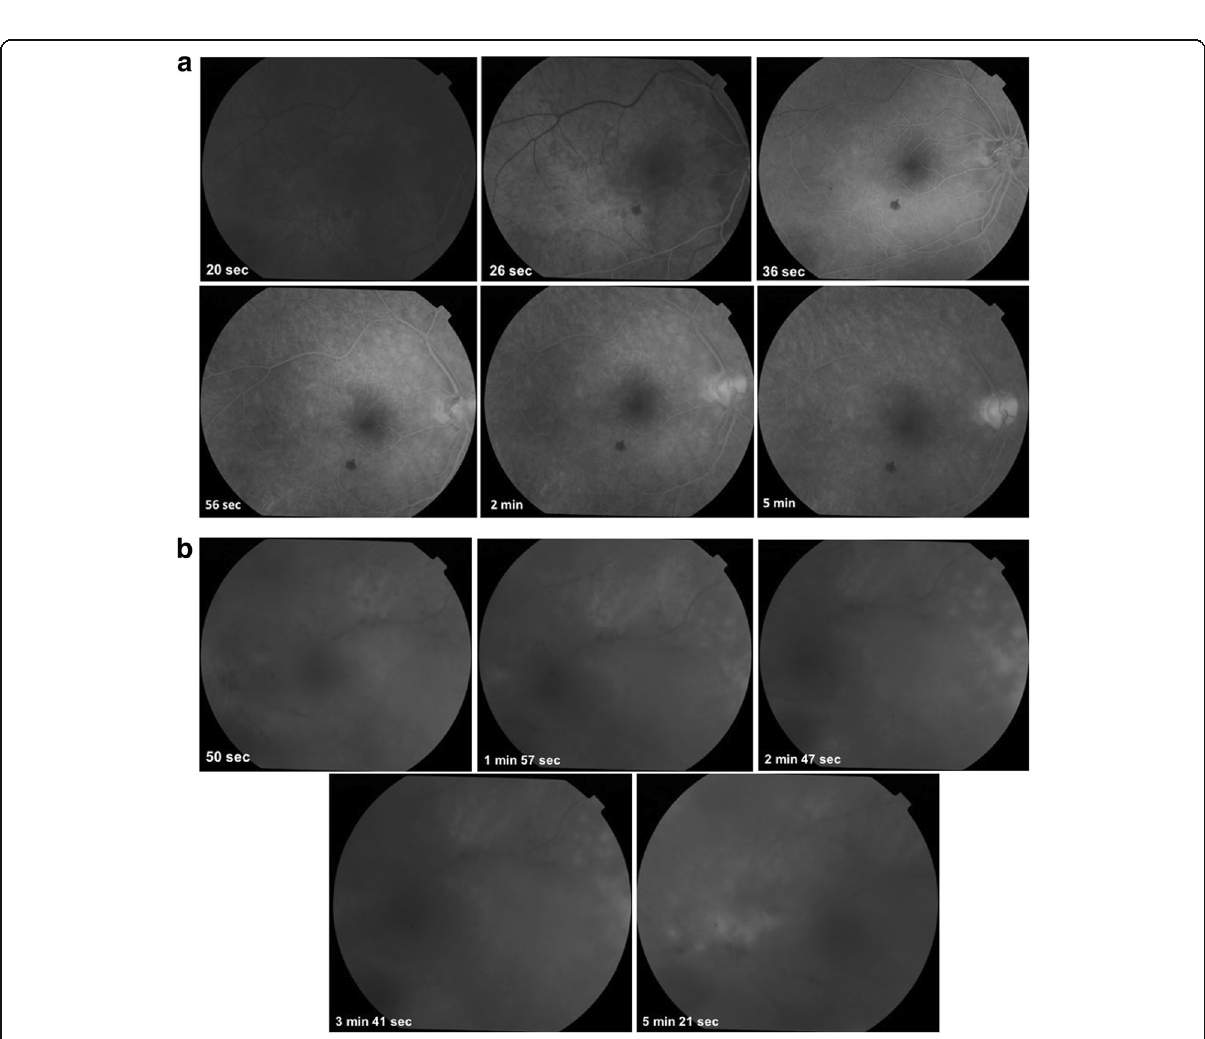
Fig. 3 a Fundus fluorescein photographs of the right eye showing delayed arterial filling corresponding to the area of retinal edema. b Fundus fluorescein photographs of the left eye showing early patchy hyperfluorescence corresponding to the areas of retinitis and disc leakage in the late phase